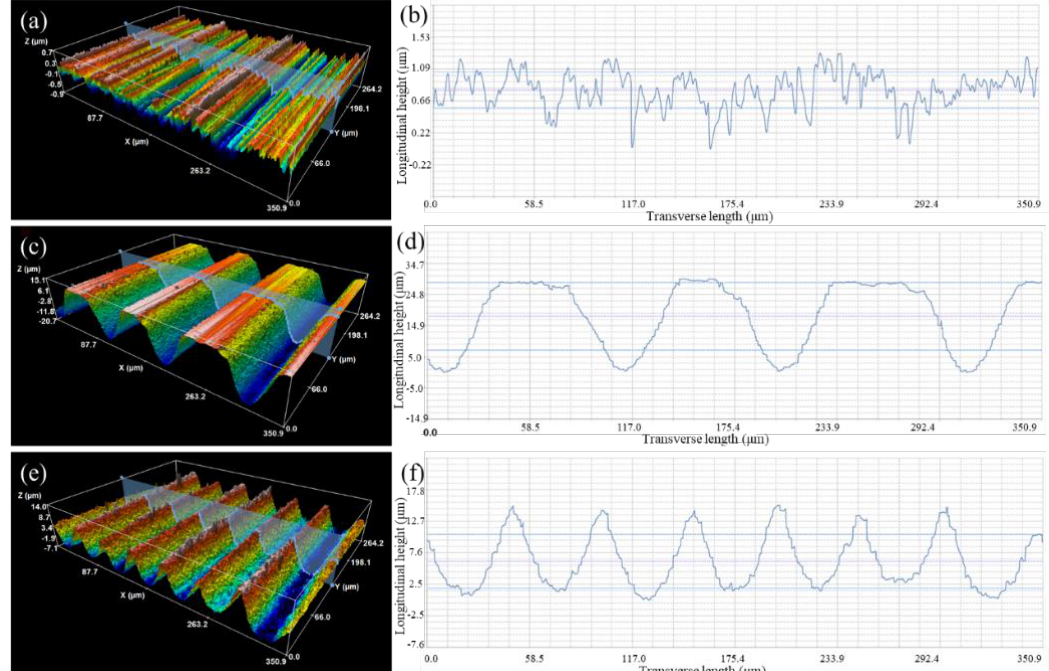
Figure 2. Surface profile shape curve of silicon nitride: ( a , b ) pristine surface; ( c , d ) loose surface; and ( e , f ) dense surface.